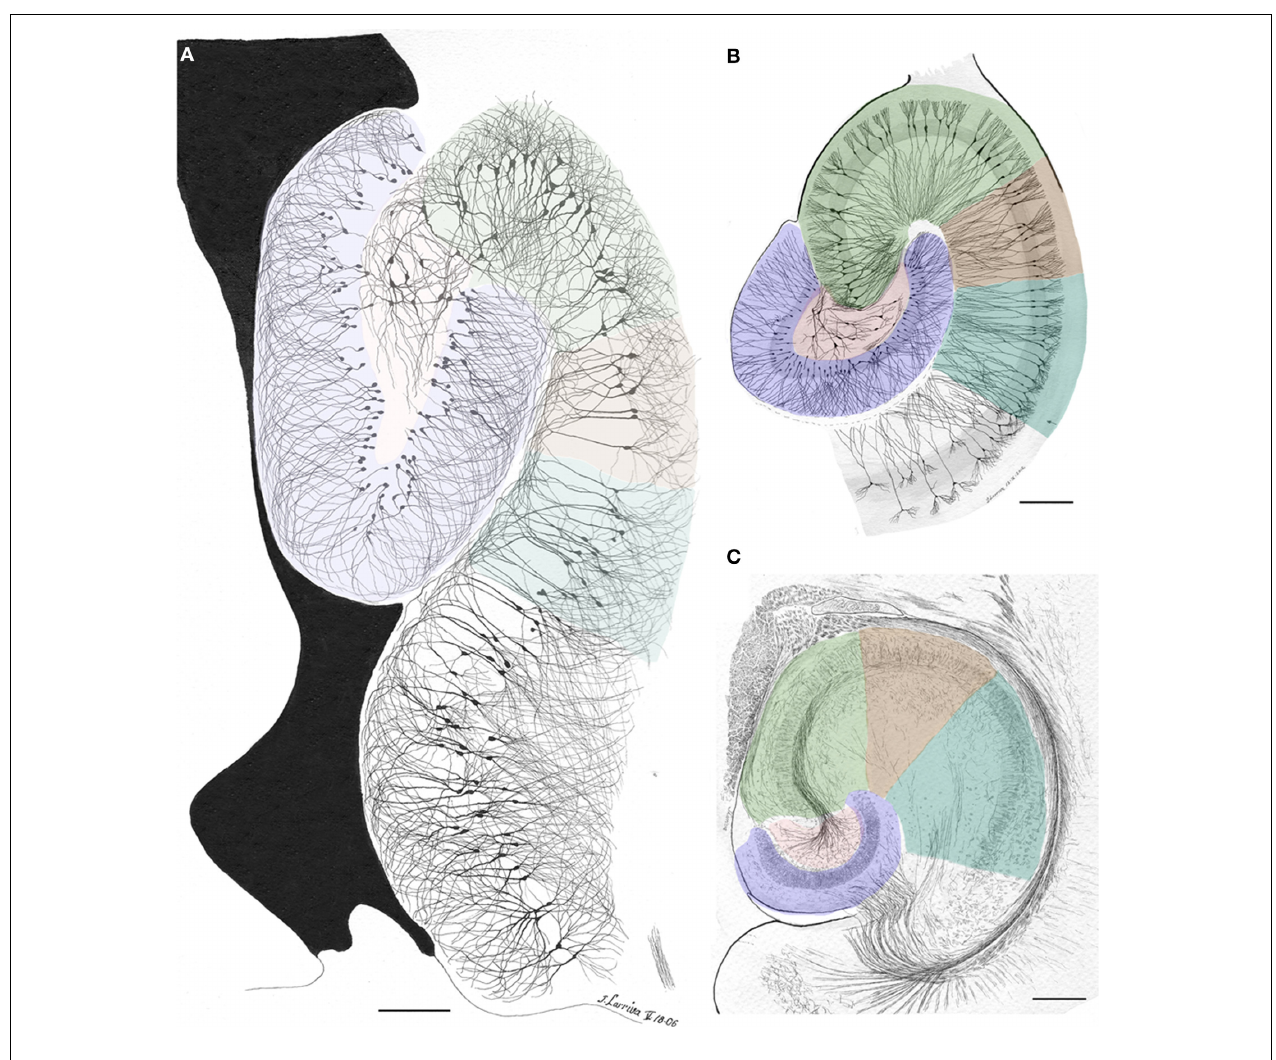
FIGURE 5 | Survey camera lucida drawings by the present author depicting the Ammon’s horn sectors in accord with Lorente de Nó parceling (colored). (A) Sagittal section through the dorsal hippocampus. Golgi-Cox technique. (B) Horizontal section through the ventral hippocampus